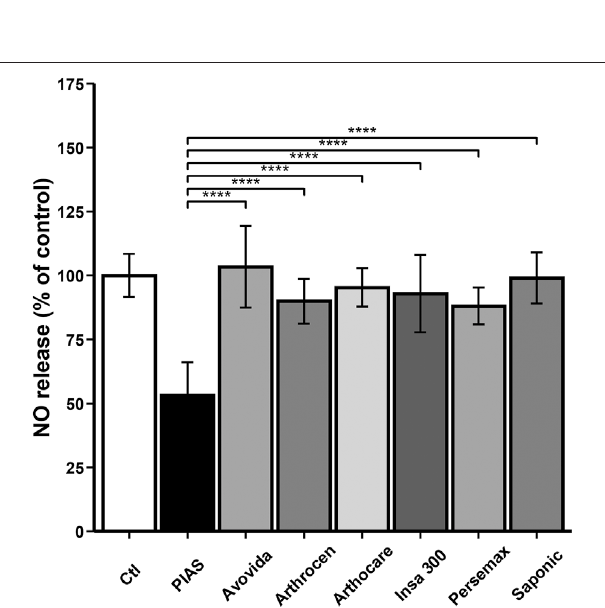
FIGURE 2 | Effect of ASU products tested on total NO production. The chondrocytes were cultured for 12 days either without any ASU (negative control, Ctl) or with 10 µg/ml of either PIASCLEDINE-ExpASU ® (PIAS) or one of the six other nutraceutical products being evaluated in comparison, namely, Avovida, Arthrocen, Arthocare, Insaponi fi able 300 (Insa 300), Persemax, or Saponic. Each product has been tested on six independent cultures. Each culture condition was performed in triplicates. The results are expressed as the percent control and represented by the mean ± SD. **** p < 0.0001 versus PIASCLEDINE-ExpASU ®